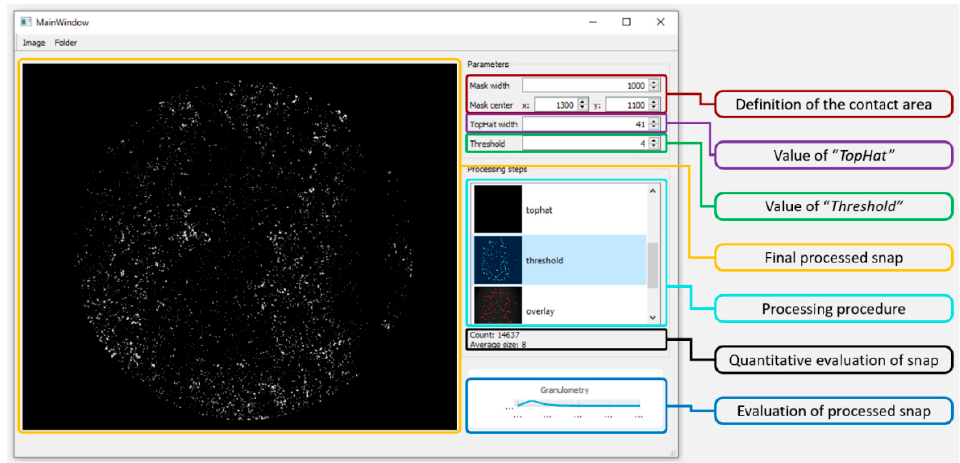
Figure 8. Evaluation software.